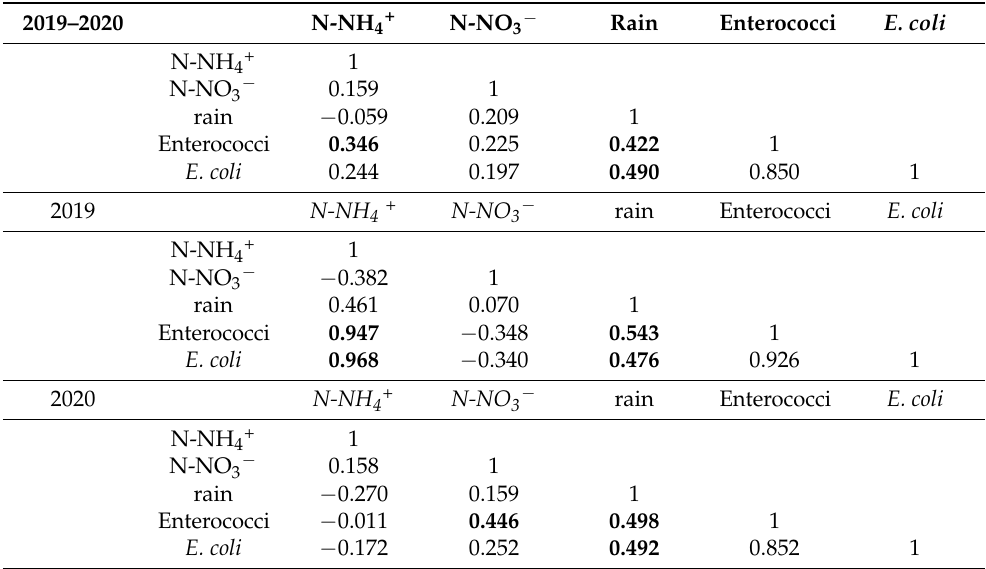
Table 1. Spearman’s rank correlation between nutrient concentrations (nitrates and ammonium), faecal bacteria ( E. coli and enterococci) and rainfall in the site of the Arzilla River during 2019–2020 events. In bold significant values reported ( p <